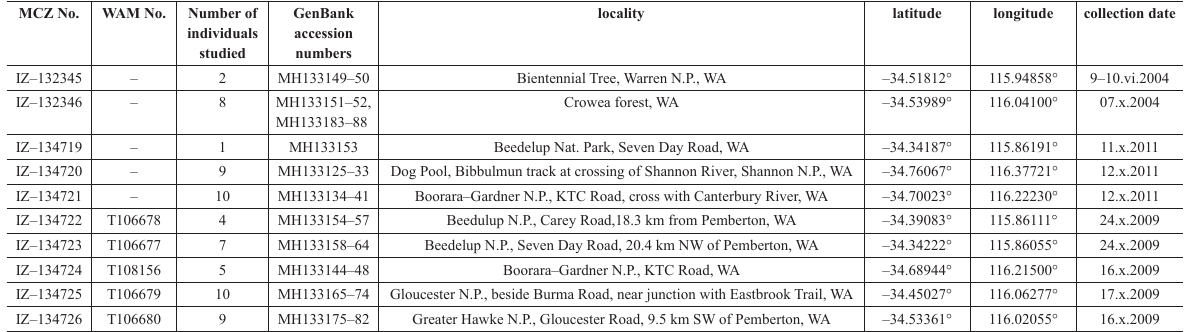
Table 1. Details on individuals and localities. Collection number for the Museum of Comparative Zoology (MCZ) and the Western Australian Museum (WAM) are provided. WA, Western